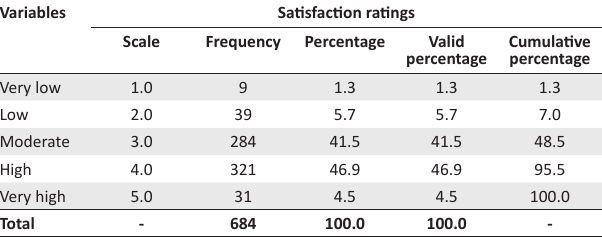
TABLE 3: Overall service quality satisfaction ratings of South African owned airlines. Variables